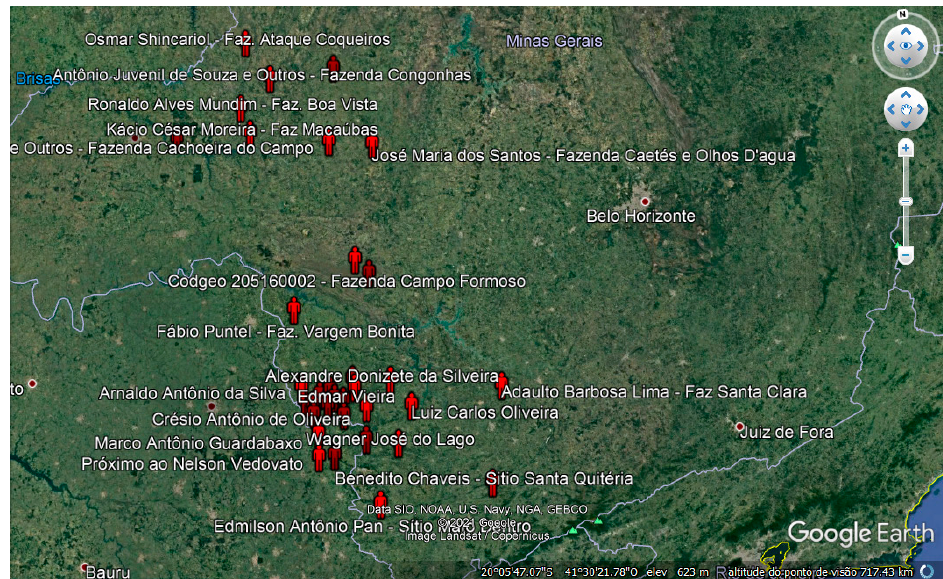
Figure 1. Expansion to 35 properties to validate the models developed to compose the coffee rust forecast system in the southern and savanna municipalities of the Minas Gerais state, Brazil.